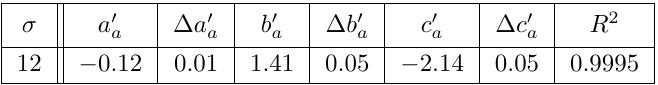
. R 2 is the R-squared goodness of b